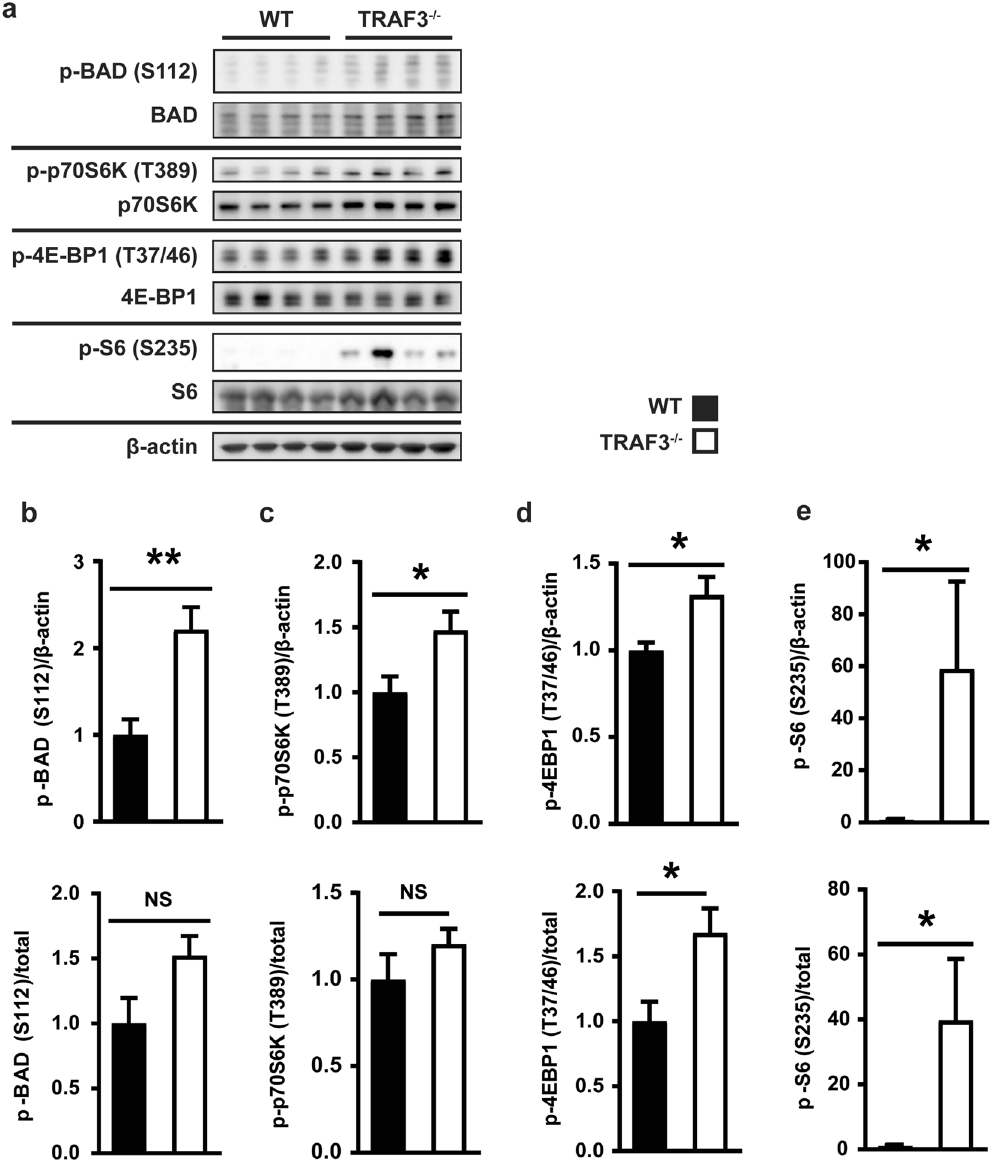
Figure 2. Effect of loss of TRAF3 on Pim2 target phosphorylation. ( a ) Whole cell lysates of WT and TRAF3 − / − B cells were analyzed with WB for protein expression. Each lane represents an individual mouse. ( b – e ) Relative levels of p-BAD S112, p-p70S6K T389, p-4E-BP1 T37/46, or p-S6 ribosomal protein S235 were normalized first to the β -actin loading control (top row) or total BAD, p70S6K, 4E-BP1, or S6 (bottom row) and then to the average normalized WT value. Graphs depict mean values ± SEM. Unpaired t test was used in ( b – d ) and Mann Whitney test was used in ( e ) to evaluate differences for statistical significance ( * p < 0.05, ** p < 0.01; N =